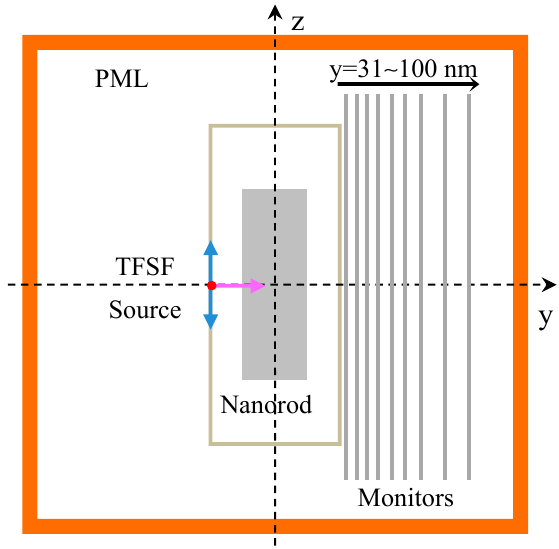
Figure 3. Schematic illustration of the finite-difference time-domain (FDTD) simulation domain of the silver nanorod when the incident TFSF source impinges on the nanorod surface at normal incidence along the y-direction (marked by the pink arrow), TE and TM polarizations are correspondingly denoted by the blue arrow and the red dot in the y–z plane. Both x- and y-span ranges were − 15 nm to 15 nm and the z-span range of the nanorod was − 50 nm to 50 nm. The simulation geometry with a mesh accuracy of 7 corresponded to the values: x = y = z = 0 and the x-, y-, and z-spans were 1100 nm, 1100 nm, and 1200 nm, respectively. Both x- and y-span ranges of the TFSF source were − 30 nm to 30 nm and the z-span range was –80 nm to 80 nm.